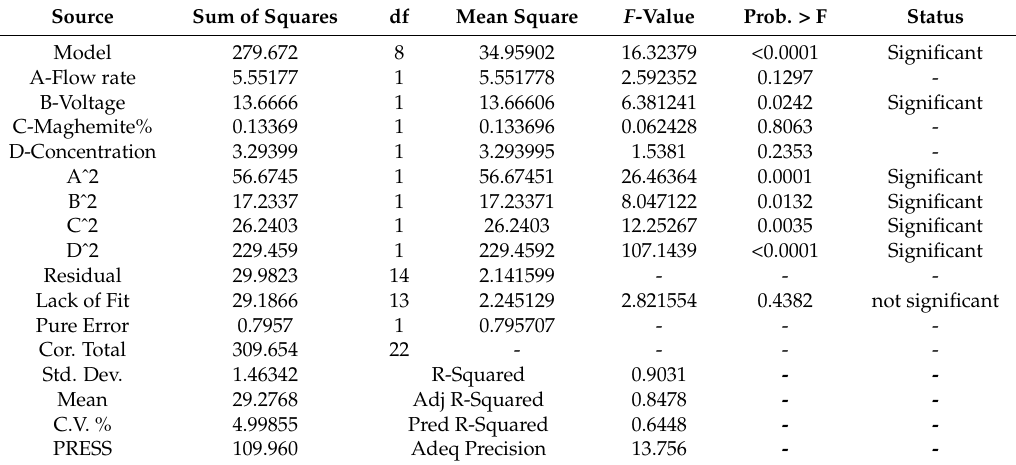
Table 6. ANOVA table for quadratic model after model reduction.